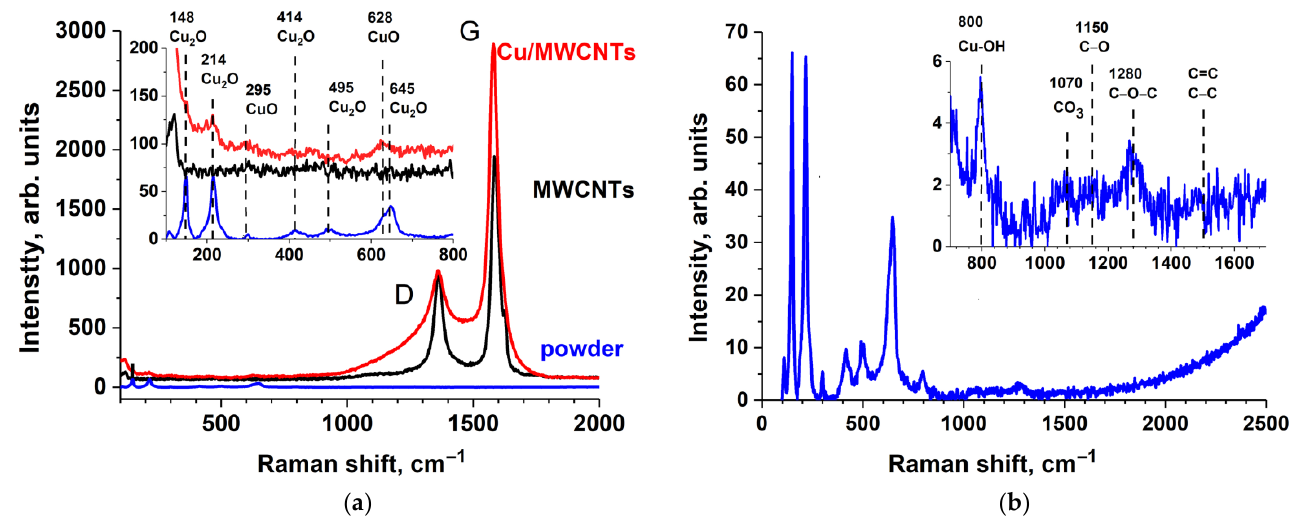
Figure 6. Raman spectra of ( a ) the initial MWCNTs, Cu/MWCNTs hybrid nanocomposite, and ( b ) powder from the reactor walls formed during the composite synthesis.